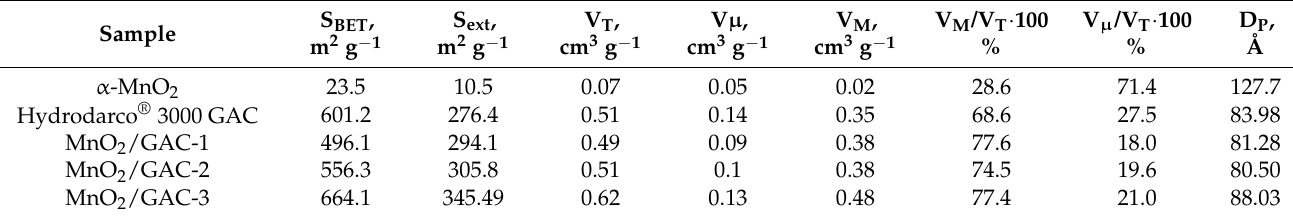
Table 2. Results from N 2 physisorption of the synthesised α -MnO 2 nanoparticles, commercial active carbon Hydrodarco ® 3000, and three MnO 2 /GAC composites prepared in this